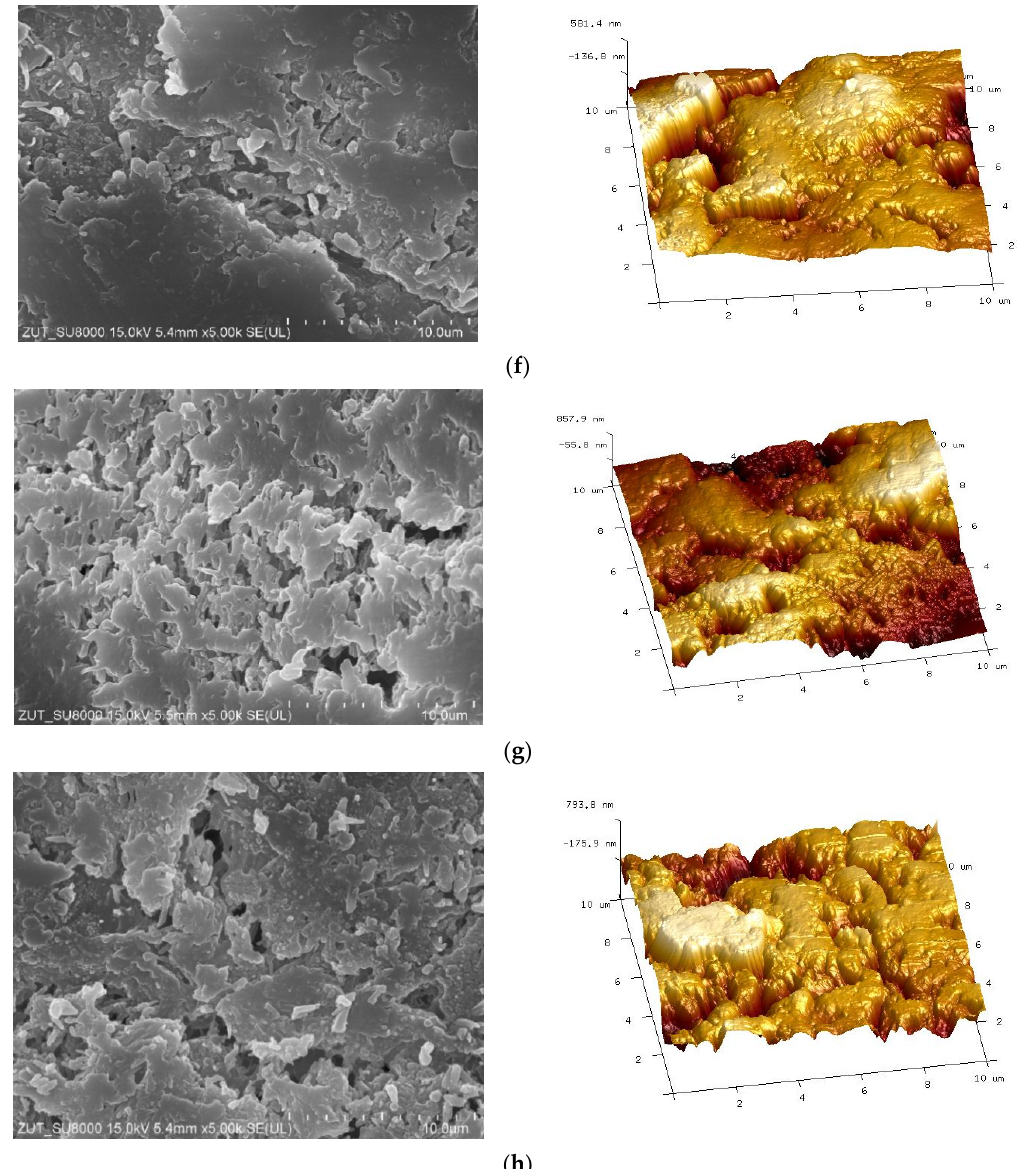
Figure 6. Scanning Electron Microscopy (SEM) (the left side) and Atomic Force Microscopy (AFM) (the right side) surface images of studied membranes: ( a ) #0; ( b ) #1; ( c ) #2; ( d ) #3; ( e ) #4; ( f ) #5; ( g ) #6; ( h ) #7.